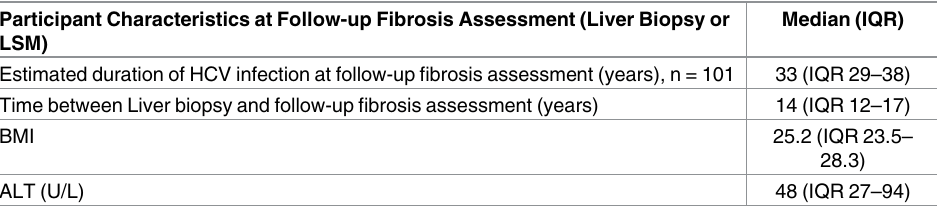
Table 2. Participant characteristics at follow-up fibrosis assessment.